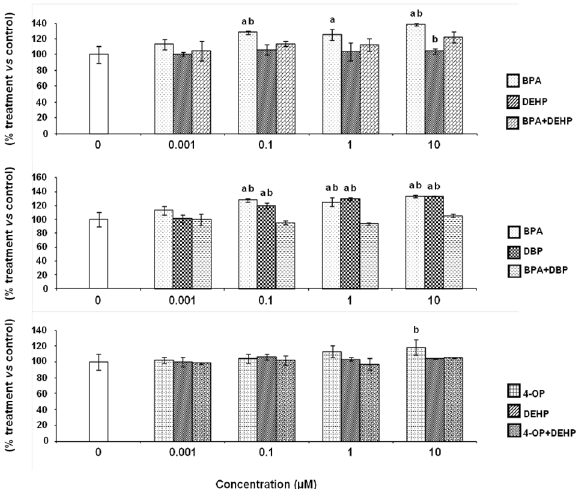
Fig 2. Effect of EDCs alone and in combination on the secretion of TNF- α by differentiated THP-1 cells. Differentiated THP-1 cells were exposed to BPA, DEHP, DBP 4-OP or a combination of both for 24 hours. Culture medium was replaced by fresh medium containing 10 ng/ml of LPS for a subsequent 24 hours of incubation. TNF- α concentrations were determined using a sandwich ELISA test. Values are means ±